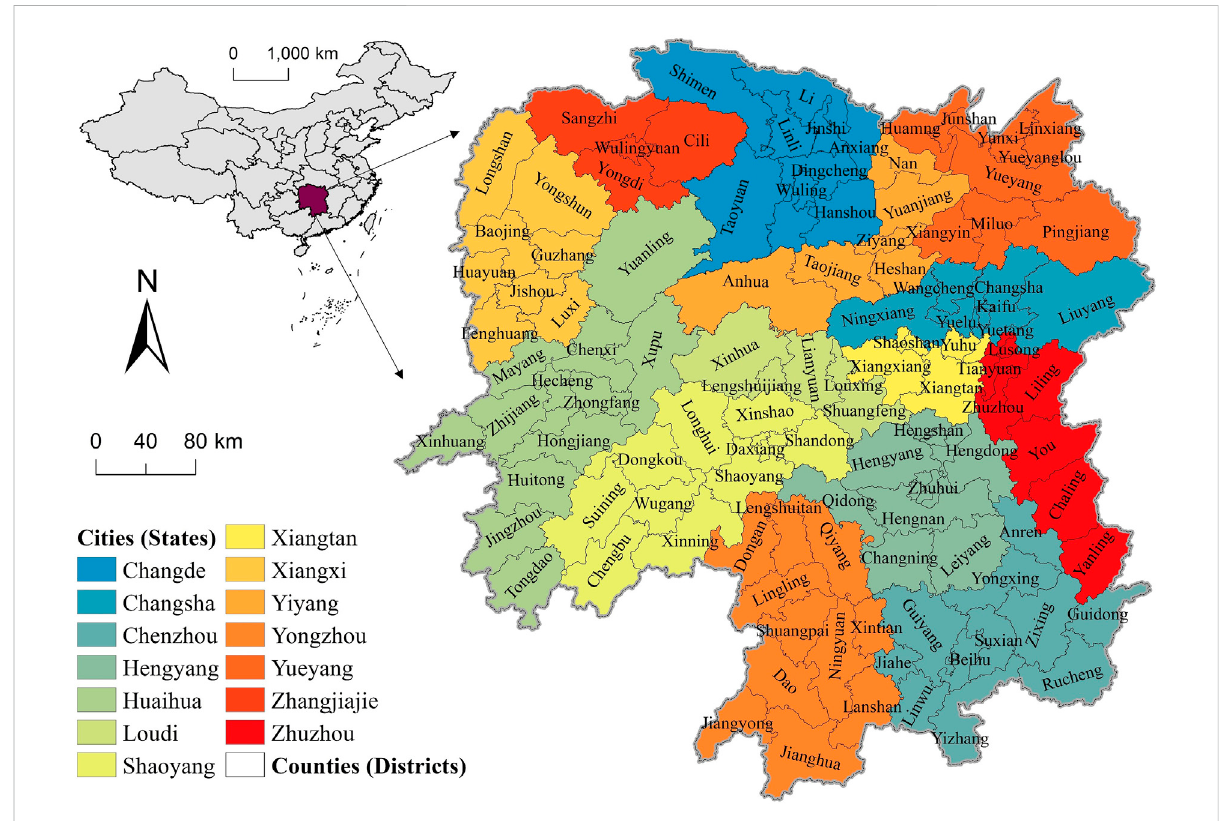
FIGURE 1 Location and administrative division of Hunan Province in